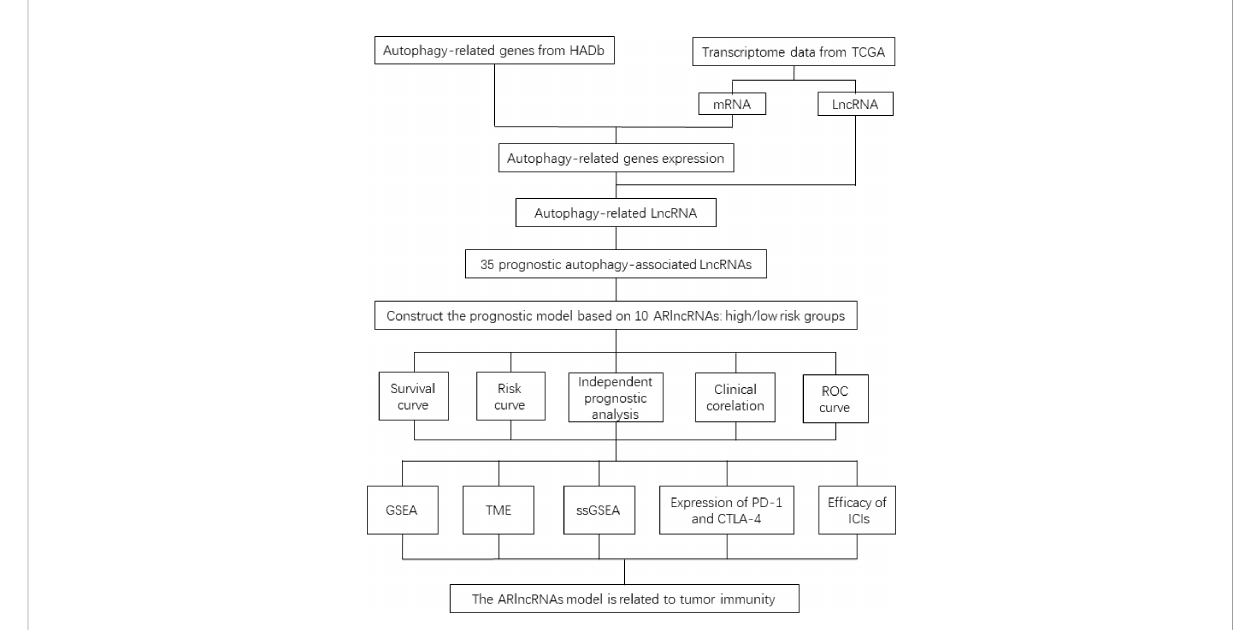
FIGURE 1 Flow chart of the construction of the prognostic mode of ARlncRNAs in breast